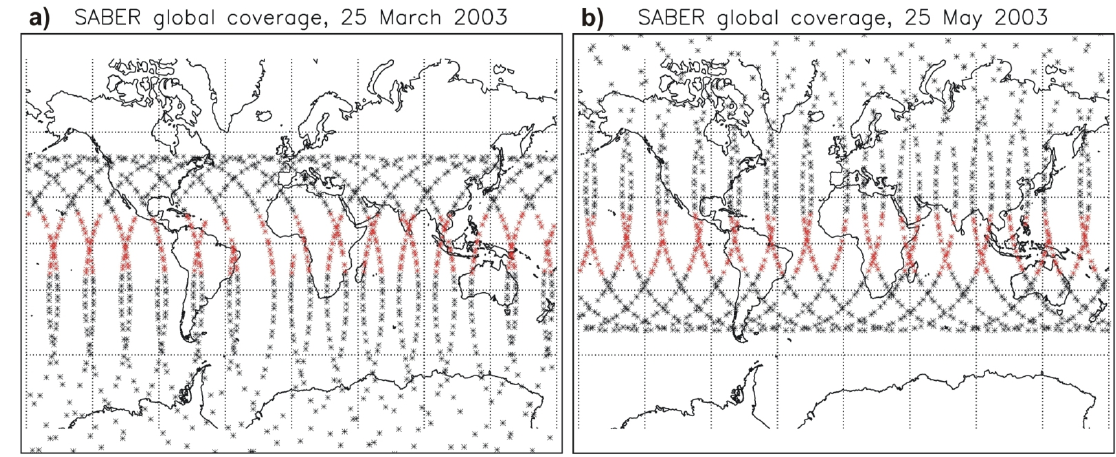
Fig. 1. Example of daily global coverage of SABER measurements. On 25 March (left panel), 2003, the instrument was facing south and on 25 May (right panel), 2003, SABER was facing north. Each asterisk resembles one profile. Profiles between 20 ◦ S and 20 ◦ N are highlighted in